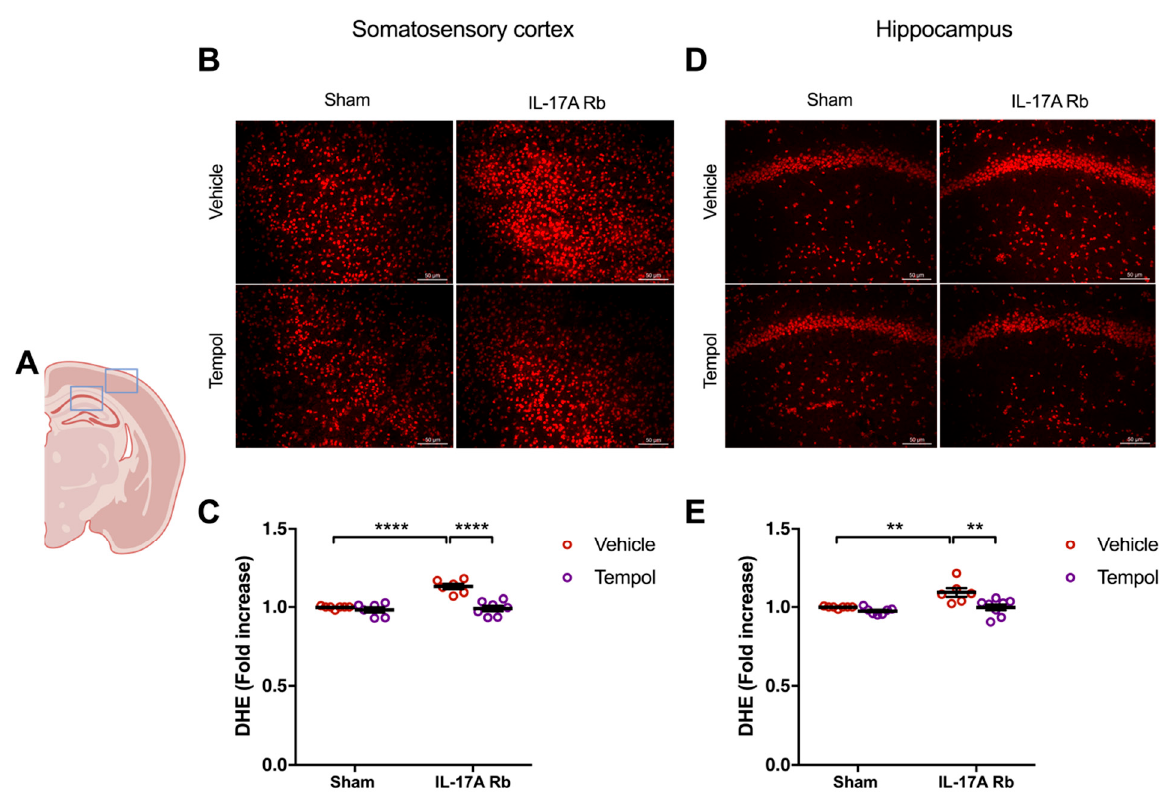
Figure 5. Tempol treatment prevents IL-17A-induced oxidative stress production . Superoxide anion production was quantified using DHE in C57BL/6 mice receiving IL-17A Rb through an osmotic minipump (50 pg/kg/h, 7 days) and treated with or without Tempol (1 mM changed every 2 days) administered in the drinking water. ( A ) Scheme illustrating the acquisition area representing the somatosensory cortex (right box) and the CA1 of the hippocampus (left box). Representative micrographs of DHE staining in ( B ) the somatosensory cortex and ( D ) the CA1 of the hippocampus (50 µ m scale). The graphs depict the ratio of fluorescence compared to control mice in ( C ) the somatosensory cortex and ( E ) the hippocampus. Data were analyzed using an ANOVA for factorial design followed by a Bonferroni post-test. ** p < 0.01 and **** p < 0.0001; n = 6–8 per group. Similarly, NOX2 -/- mice that received IL-17A Rb presented a similar level of superoxide anion production in the somatosensory cortex ( p < 0.001) and the hippocampus ( p < 0.0001) compared to the control mice (Figure 6).